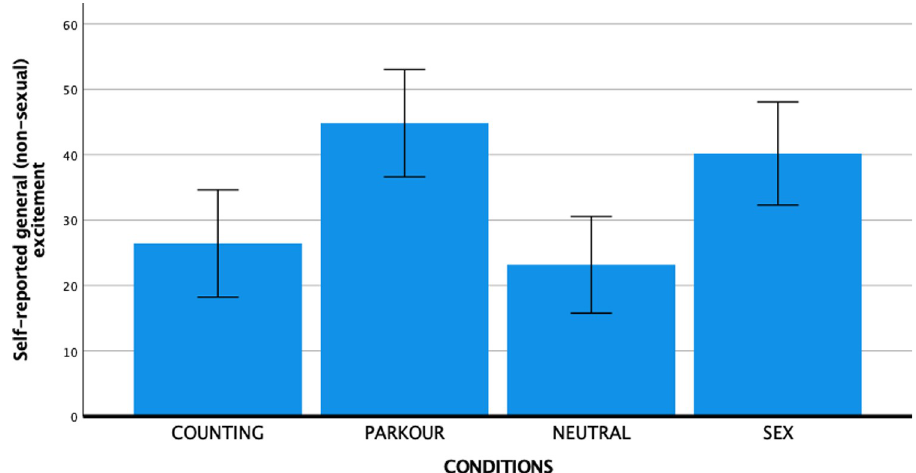
Fig 3. Mean self-reported generalized arousal per condition with error bars representing 95% confidence interval.